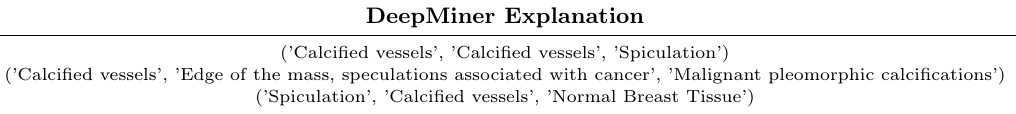
Table 1. DeepMiner explanations presented for the first three cases in the malignant vs. benign expert classification experiment of Section